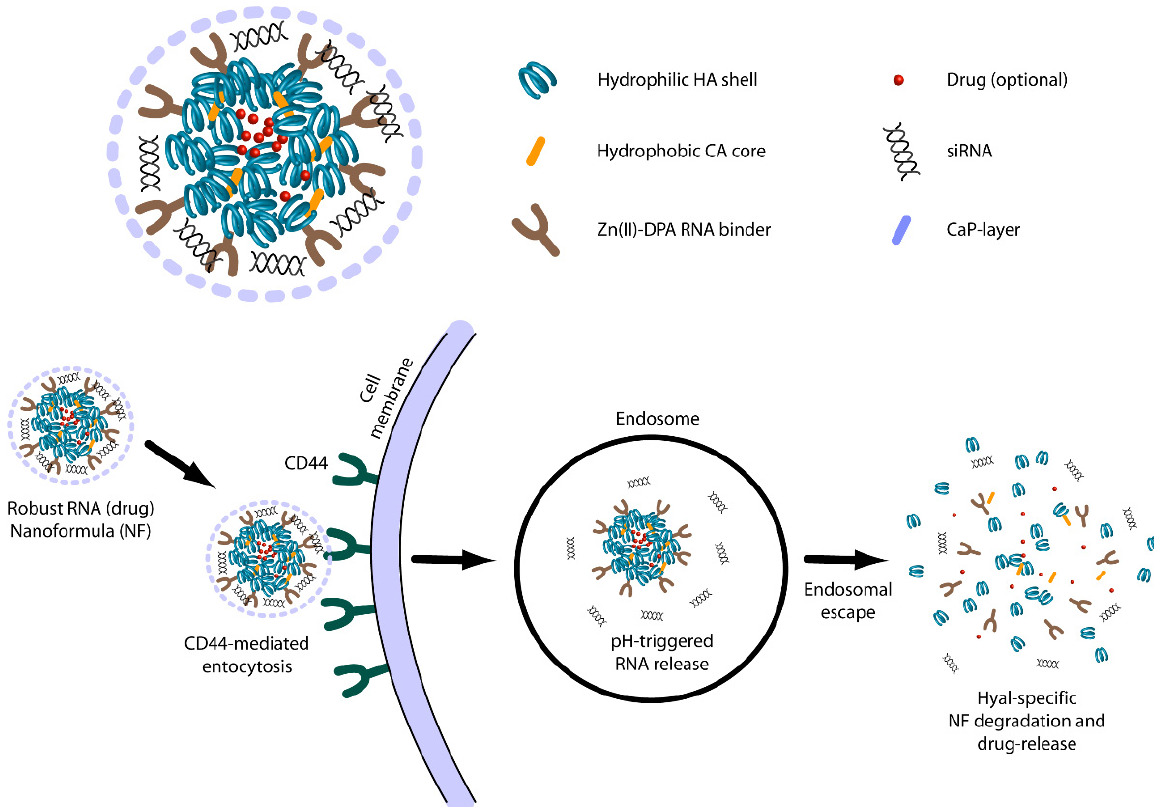
Figure 8. HA-based delivery for siRNAs proposed by Choi et al.